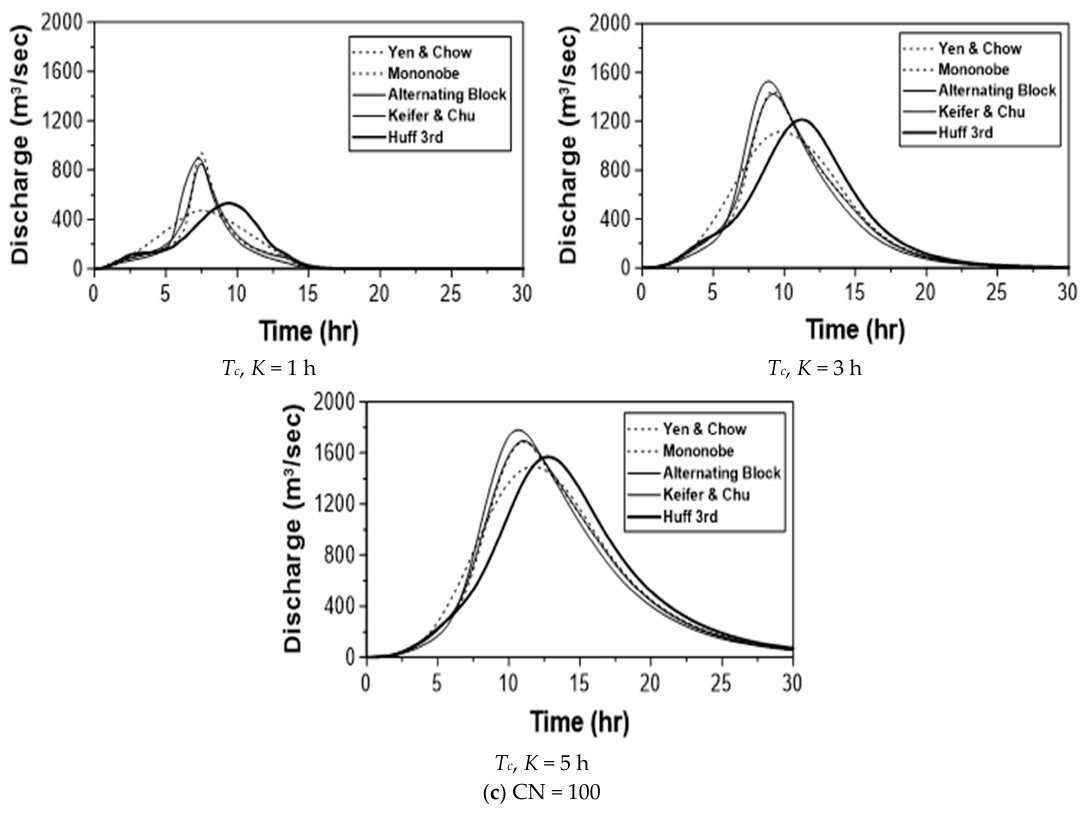
Figure 7. Comparison of runoff hydrographs derived with different rainfall temporal distribution models for the annual maximum rainfall event in 1997.